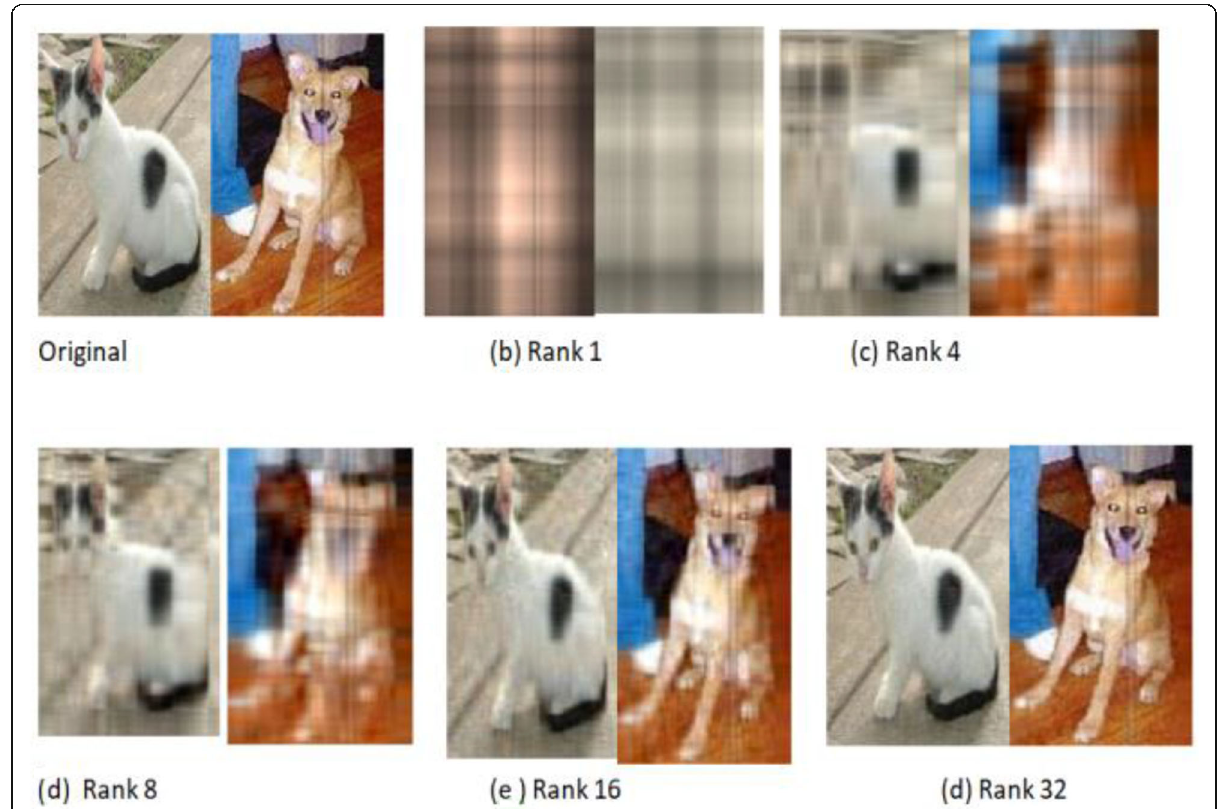
Fig. 2 Original Image Compared with CPD Generated